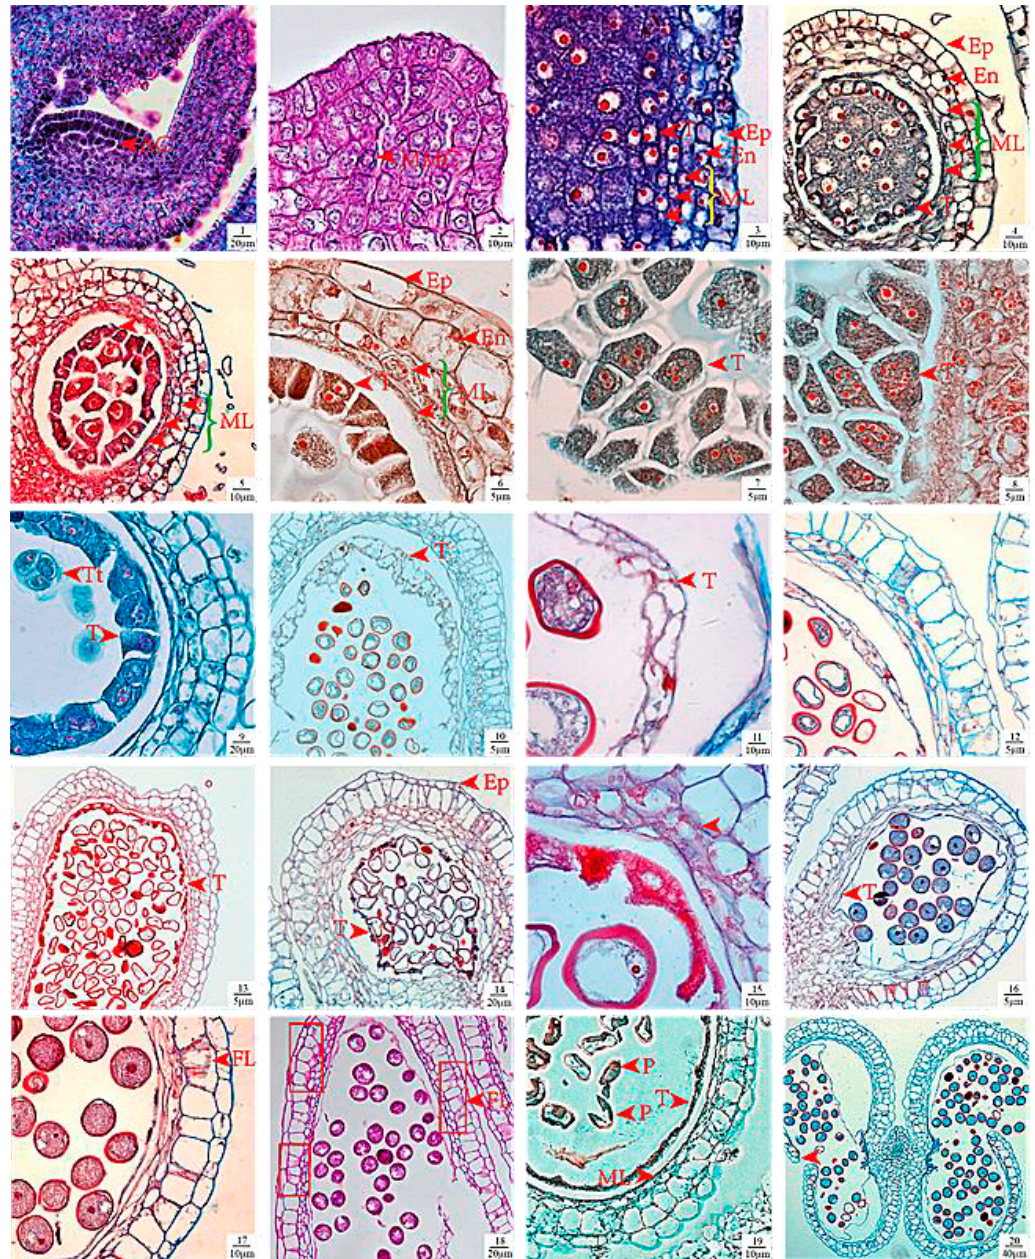
Figure 6. Development of male flower wall and tapetum of anther. Formation of the anther wall in Carya illionensis . AC, Archesporial cell; Ep, epidermis; En, endothecium; ML, middle layer, MMC. Microspore mother cell; Ta, Tapetum; FL, Fibrous layer, Tt, Tetrahedral tetrads; VC, vegetative cell; GC, generative cell. 1) Anther wall of primary sporogenous cell stage. 2) Anther wall of secondary sporogenous cells. 3) Anther wall of pollen mother cells: 6 layers, tapetum initial differentiation. 4) Pollen mother cells are separated from each other and differ- entiating tapetal cells are separated. 5) Microspore meiosis before the prophase, tapetum elongated and turn flattened. 6) Microspore meiosis I late, tapetal cell division. 7) Microspore meiosis I late transition period, heterotic tapetum division peak period. 8) Heterogeneous multi- core tapetum; the middle containing starch granules and other nutrients. 9) Tetrad stage, epidermal expansion, the inner wall thickening, the middle 3 layers, glandular tapetum 2 to 3 layers. 10) Late uninucleate microspores: The tapetum wall beginning to disintegrate. 11) Tapetum showing disintegration and became thinning. 12) The inner layer of the tapetum was almost completely dissolved. 13) The tapetum had dis- solved, leaving only a monolayer; the cell wall had dissolves, leaving the edge useless. 14) The tapetum was disintegrated outside the tangen- tial wall and the middle layer was flattened. 15-16) The tapetum is almost completely dissolved. 17) The middle layer began to dissolve and banded; anther chamber wall showed fibrous thickening. 18) The cell walls of chamber showed fibrous thickening, and the middle layer had dissolved. 19) 2 nucleated stage, the middle layer is almost completely dissolved. 20) Interventricular rupture, pollen sac